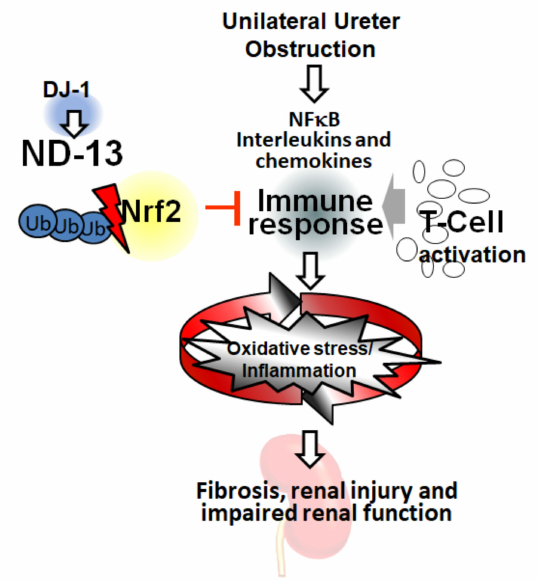
Figure 8. Working hypothesis. ROS and inflammation induced by unilateral ureter obstruction increase interleukin and chemokine expression activating the immune response. This inflammatory / oxidative environment leads to a vicious cycle, which may produce fibrosis and induce renal damage and kidney dysfunction. DJ-1 prevents the ubiquitination of Nrf2 and amplifies its response. Nrf2 may be acting by attenuating the oxidative stress and inflammation, leading to a reduced cytokine expression and preventing inflammation, resulting in protection of the renal